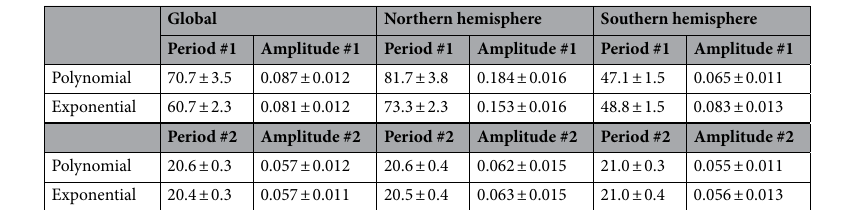
Table 1. Comparison of the results for global and hemispheric annual mean surface temperatures. The periods are given in years and the amplitudes are given in K. All uncertainties are 1σ